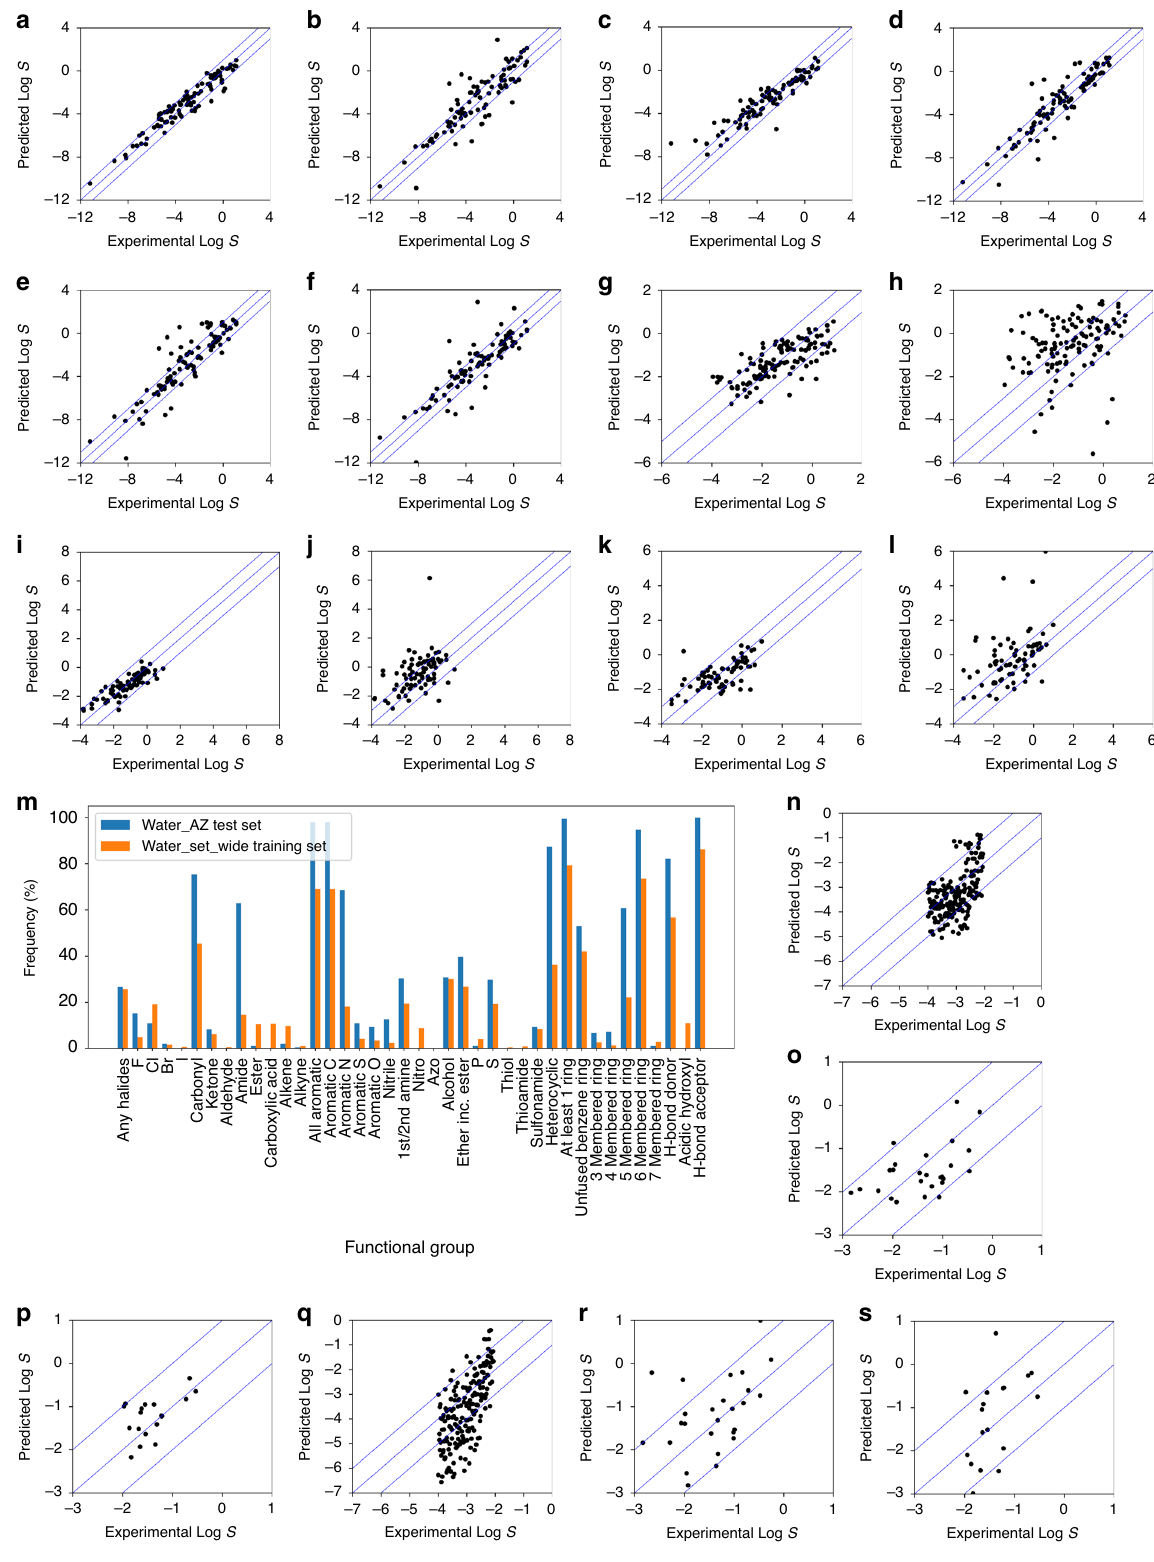
Fig. 3 Benchmarking results against other predictive models. Predicted vs experimental LogS for Water_set_wide a ET model; b GSE model; c AquaSol model; d EPI Suite 1 model, e EPI Suite 2 model; f COSMOtherm calculations; for Ethanol_set g , ET model; h COSMOtherm calculations; for Benzene_set i ET model; j COSMOtherm calculations; for Acetone_set k ET model; l COSMOtherm calculations; and prediction results using datasets from AstraZeneca m functional group distribution analysis for dataset from AstraZeneca and Water_set_wide ; predicted vs experimental LogS for n ET model for AZ_water (without m.p.); o ET model for AZ_ethanol (without m.p.); p ET model for AZ_acetone (without m.p.); q COSMOtherm calculations for AZ_water